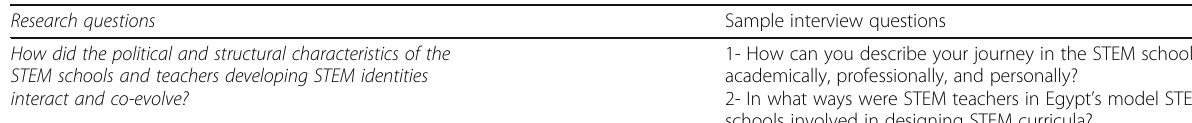
Table 3 Research questions aligned with interview